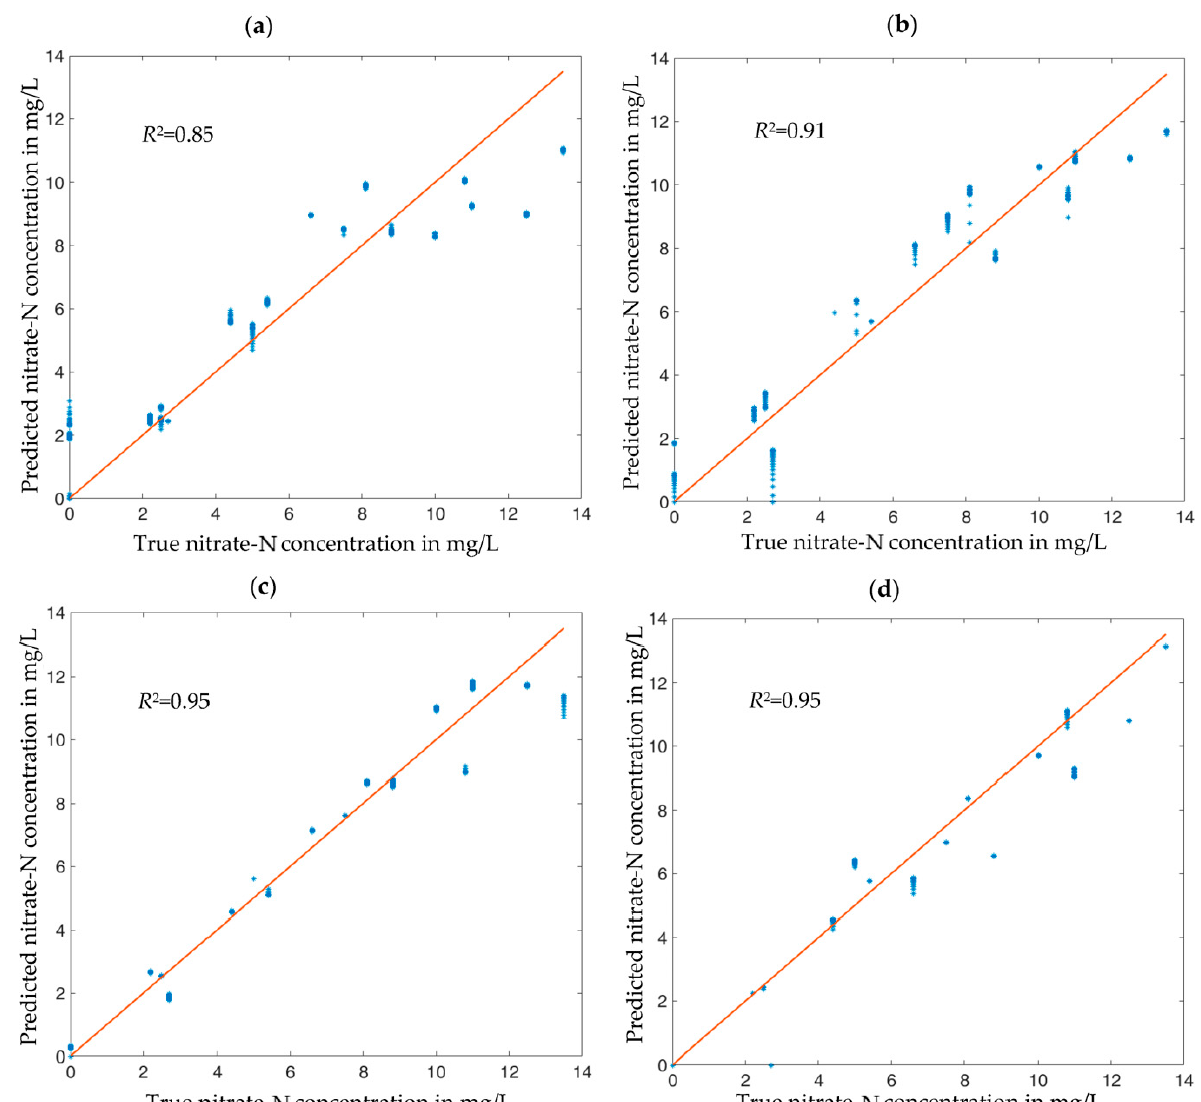
Figure 7. Nitrate-N concentrations predicted by LSTM-built regression models from measured impedance spectra of synthetic soil samples plus selected other physical variables. ( a ) Results based on the susceptance spectrum B as feature. ( b ) Results with features B and θ w . ( c ) Results with features B , θ w , and ρ b . ( d ) Results with features B , θ w , ρ b , and G . Blue dots: estimation results for each of the 360 validation data sets. Straight lines: goal (predicted value = actual value). The R 2 values shown in each chart are the coefficients of determination between true and estimated concentrations.